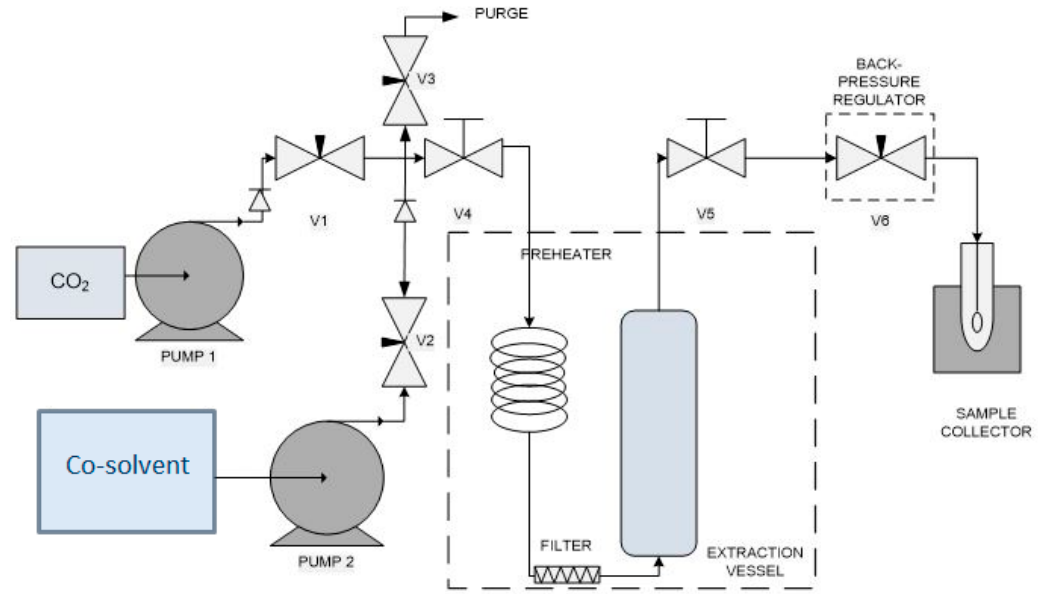
Figure 4. Design of the experimental system used for the supercritical fluid extraction system with co-solvent [29].